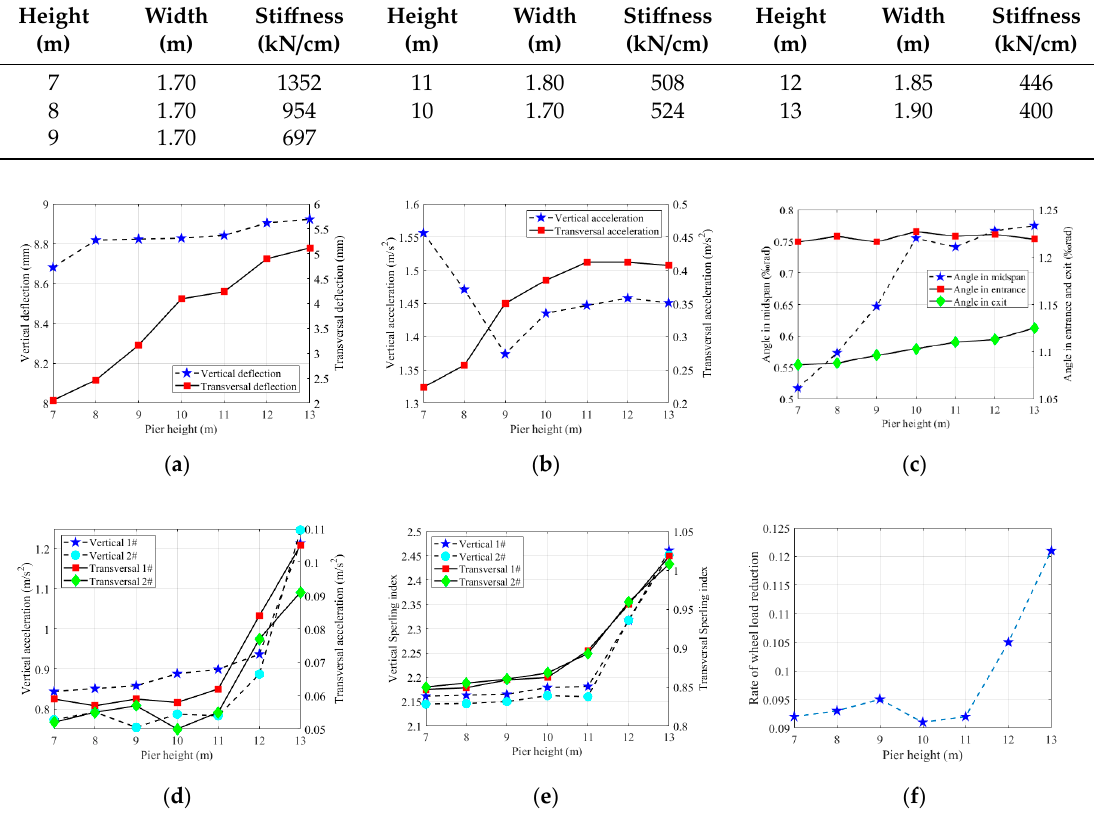
Figure 11. Responses of the bridge and the train at different pier heights—( a ) bridge deflection, ( b ) bridge acceleration, ( c ) bridge angle, ( d ) train acceleration, ( e ) Sperling index, and ( f ) rate of wheel load reduction.